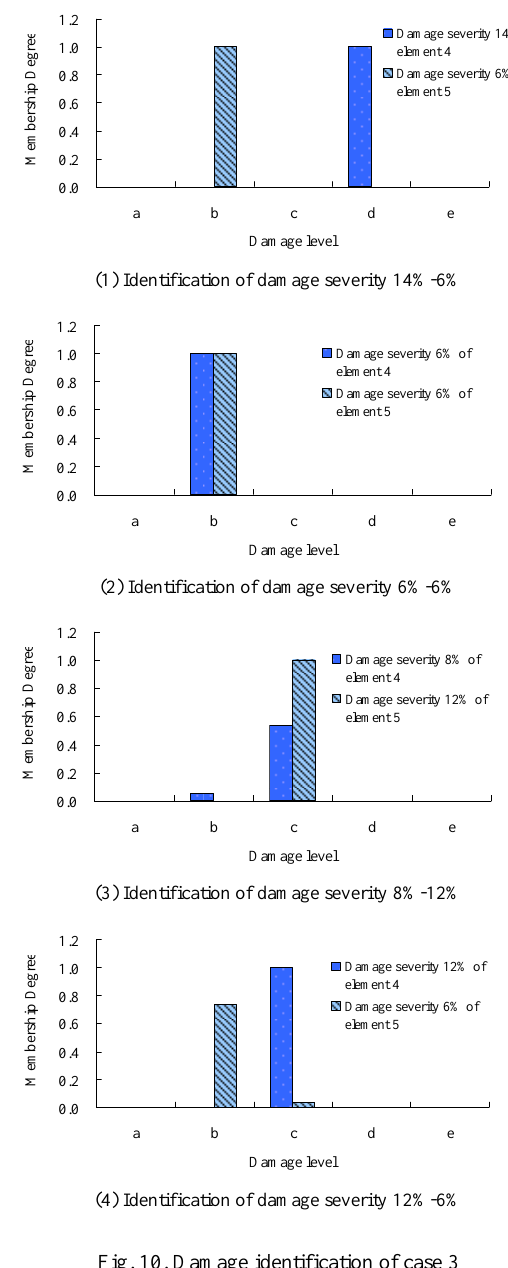
Fig. 10. Damage identification of case 3